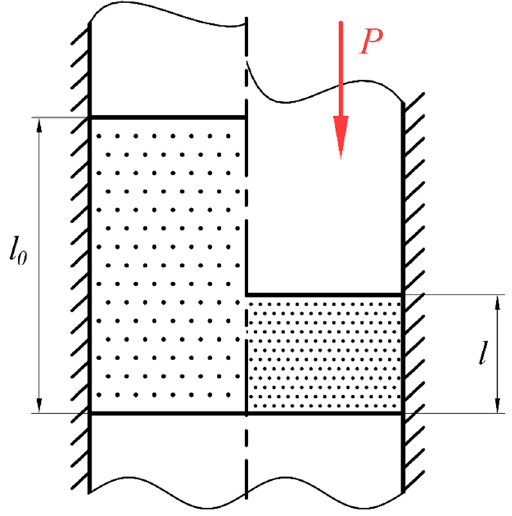
Figure 1. Schematic diagram of powder preforming in the die: P is forming pressure; l 0 is an initial height of the powder dose; l is a height of the preform.